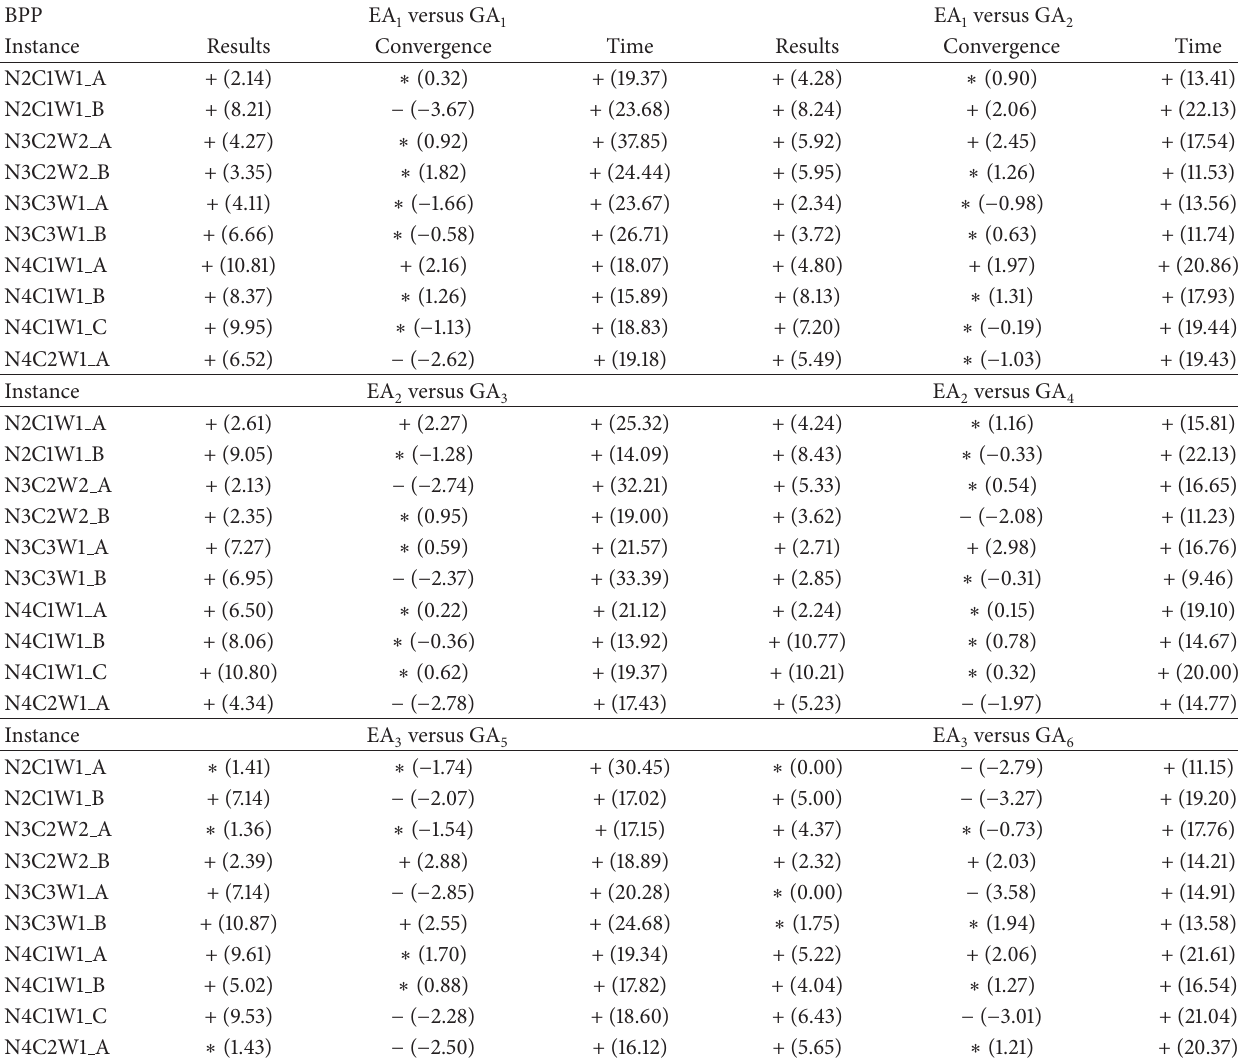
Table 13: 𝑧 -test for BPP. “+” indicates that EA is better. “ − ” depicts that it is worse. “ ∗ ” indicates that the difference between the two algorithms is not significant (at 95% confidence